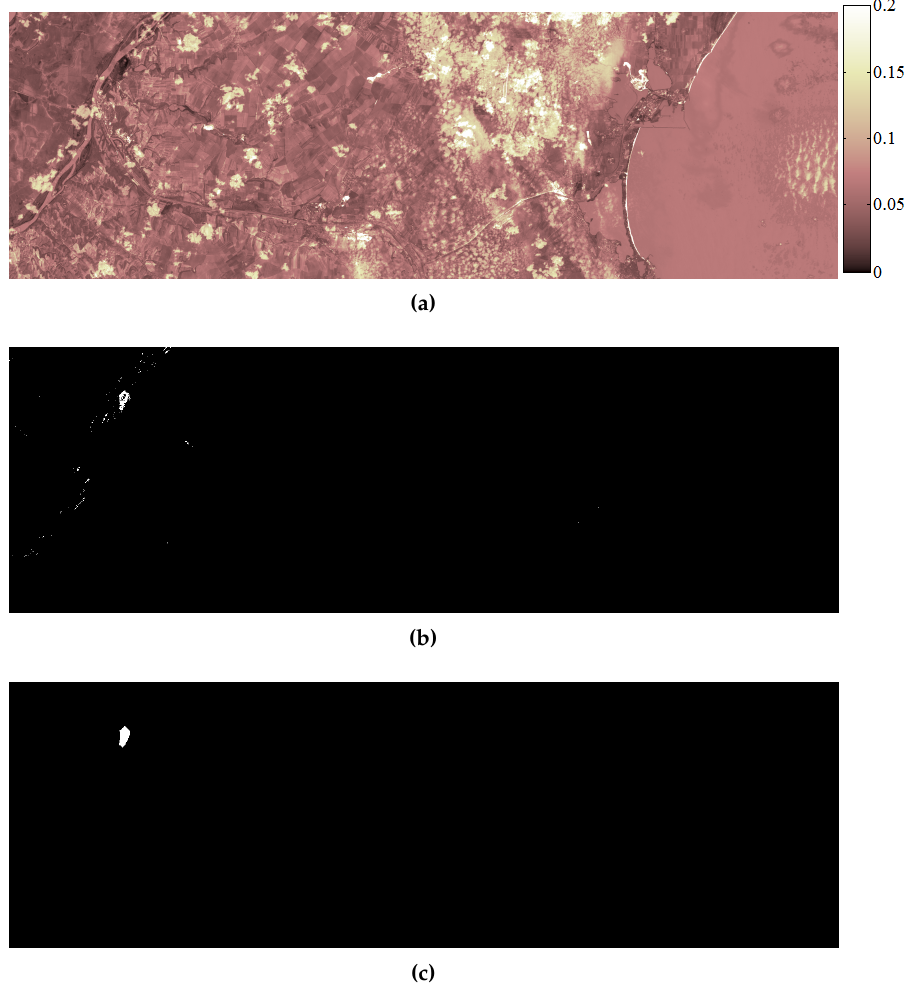
Figure 10. Delimitation of areas affected by floods in Dobrogea. ( a ) DTW distance image for a query in the flooded area. ( b ) Delimitation of the affected area using the proposed algorithm. ( c ) Ground truth marking the flooded areas. In the case of DTW distance image presented in ( a ), dark color represents similar evolutions and bright color represents non-similar evolutions, whereas in ( b ) white pixels correspond to spatio-temporal patterns that are similar to the query, which was selected from the region of